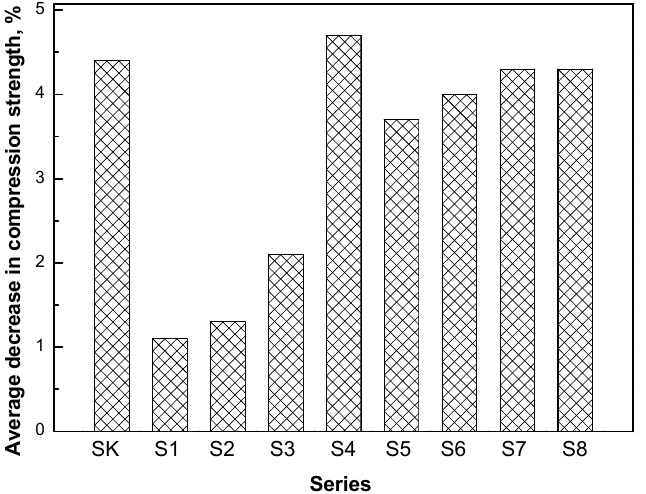
Figure 3. Average decrease in the compressive strength of the concretes after frost resistance test- ing.